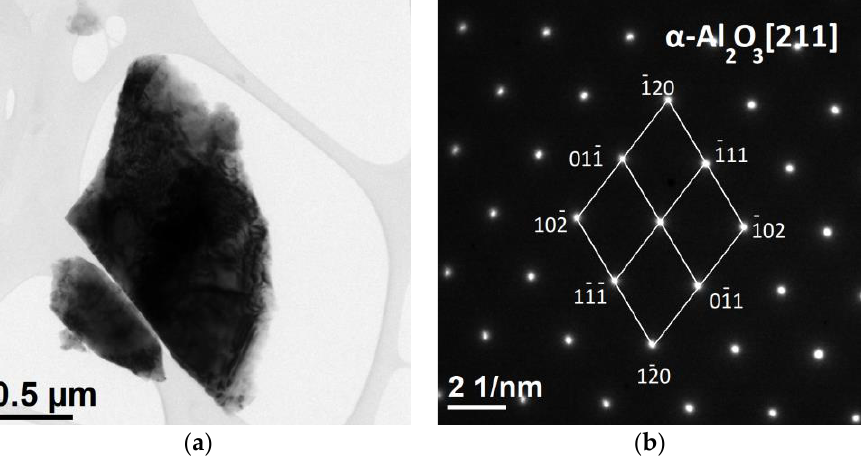
Figure 3. Microstructure of porous ceramic skeletons sintered at 1600 °C. ( a ) TEM-BF; ( b ) SAED.